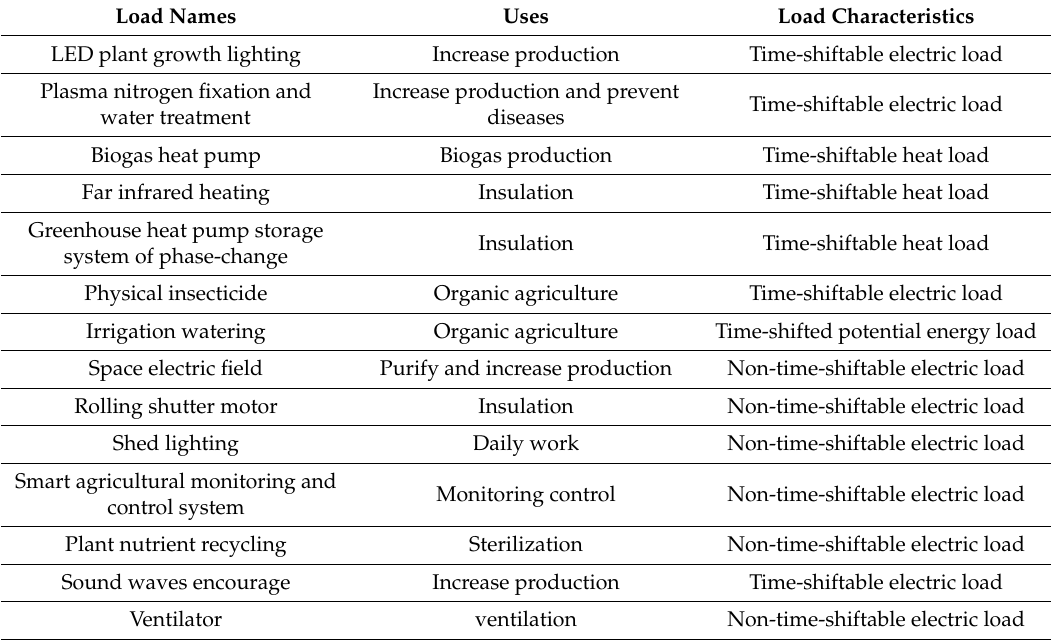
Table 1. Load characteristics classification in photovoltaic greenhouse facilities agricultural micro energy networks.